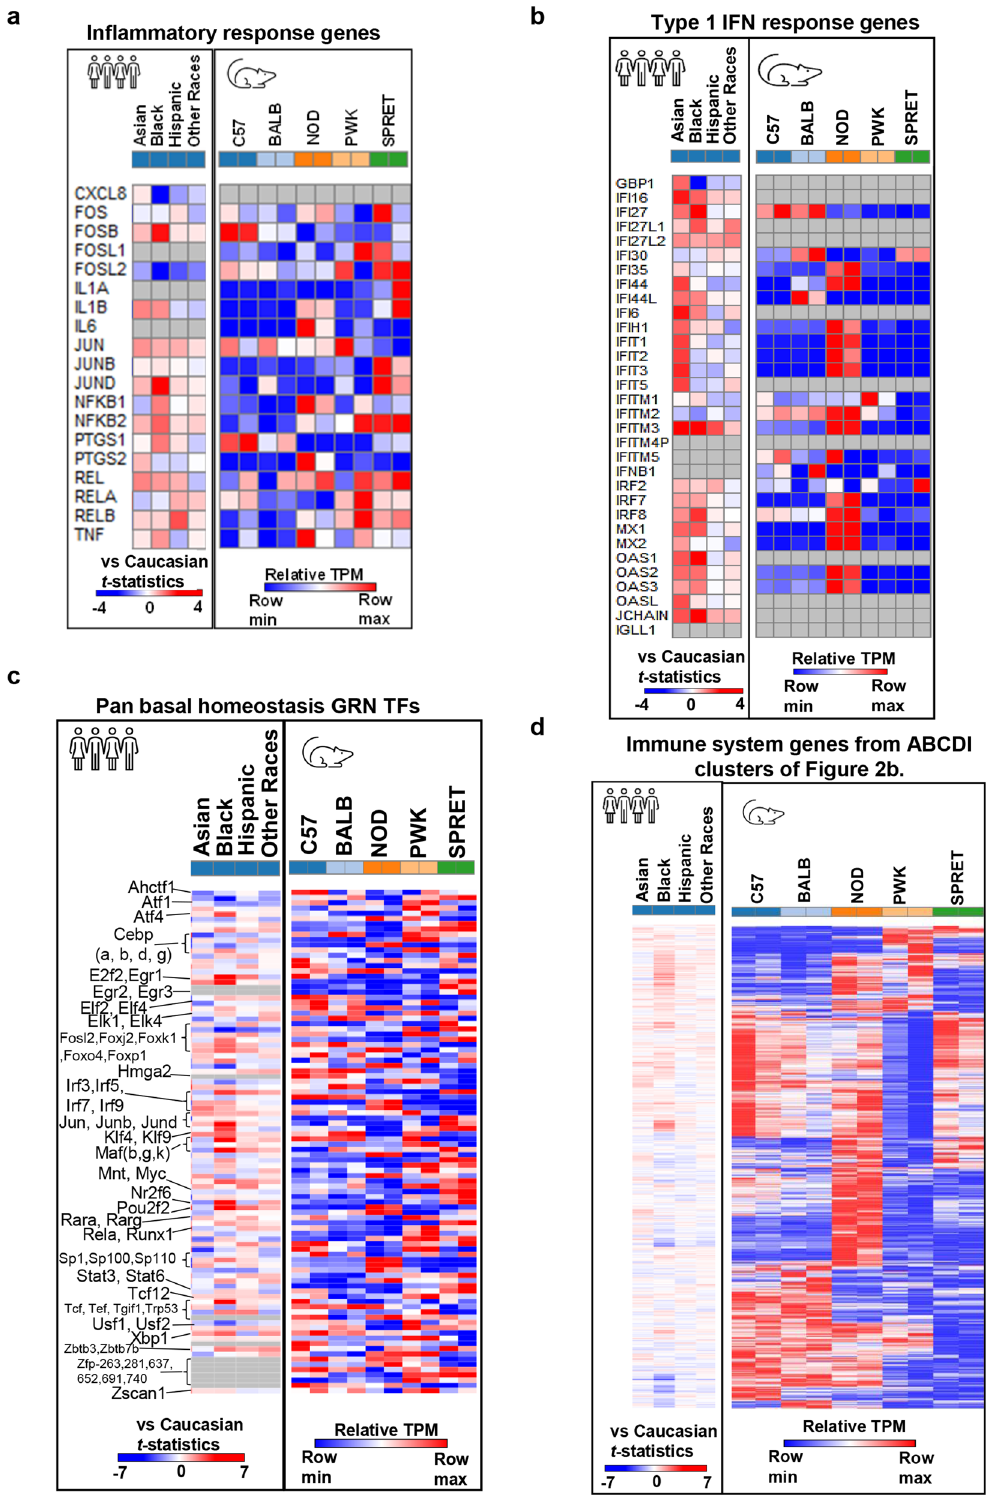
Figure 8. Transcriptome based comparative analysis identified expression disparities between the human population and five murine strains. ( a ) Heatmap of 19 inflammatory response genes expression in the different human populations (Asian, Black, Hispanic, and other races with regard to (w.r.t.) Caucasian individuals, and unstimulated macrophages of five murine strains (C57, BALB, NOD, PWK, and SPRET). ( b ) Heatmap of 32 type 1 IFN response genes expression in different human populations and unstimulated macrophages of five murine strains. ( c ) Heatmap of 96 pan basal homeostasis GRN TFs expression in different human populations and unstimulated macrophages of five murine strains. ( d ) Heatmap of 730 immune-related genes (form cluster A, B, C, d, and I of Fig. 2b) expression in different human population and unstimulated macrophages of five murine strains. Individual heatmap scale for human and murine